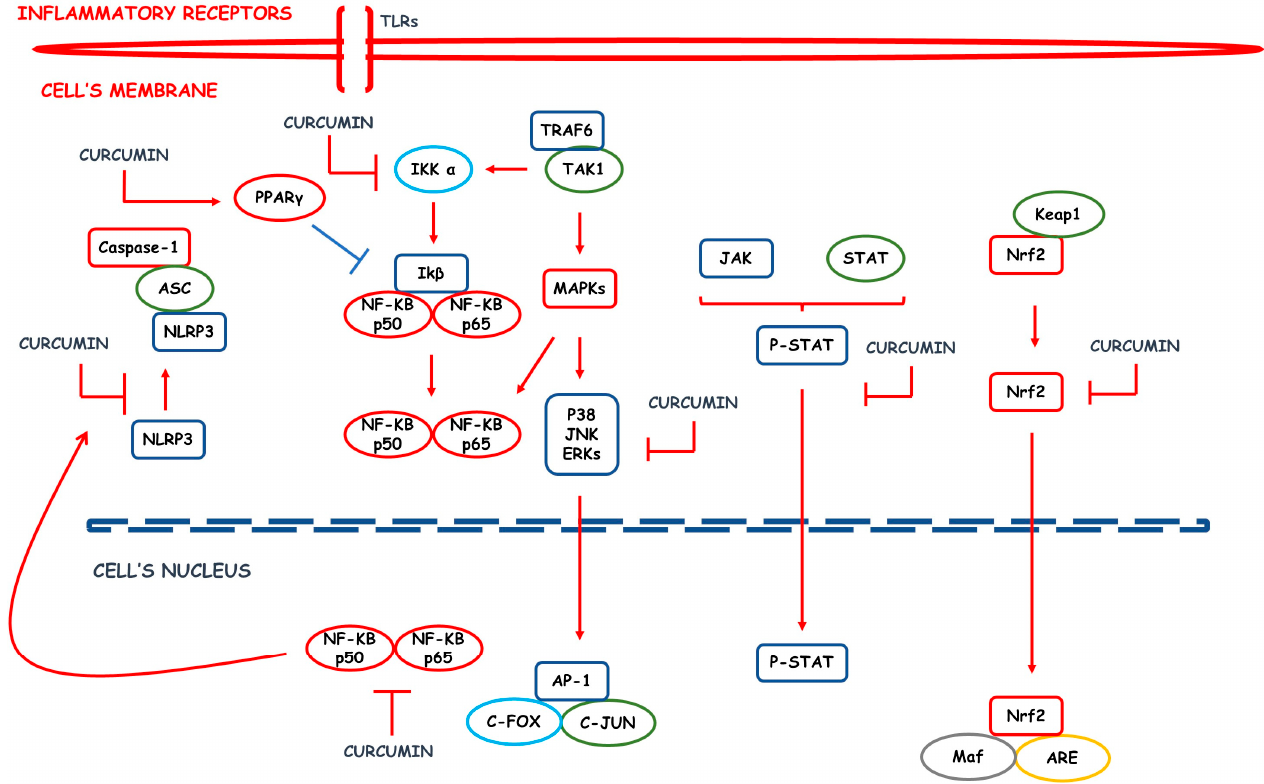
Figure 2. Most important pro-inflammatory vias involved in the occurrence of inflammatory bowel diseases that are inhibited by CUR. This bioactive compound diminishes inflammation and pro- motes antioxidant effects during in vivo, in vitro, and human studies regarding its use against IBD. The inhibition of NF-kB activation by CUR is highlighted. Ap1, apetala type 1; ARE, antioxidant redox element; ASC, apoptosis-associated speck-like protein; C-FOX, forkhead box protein C; C-JUN, transcription factor Jun C; ERK, extracellular signal-regulated kinases; IkB, nuclear factor of kappa light polypeptide gene enhancer in B-cells inhibitor; IKK a, I κ B kinases α ; JAK, Janus kinase; JNK, N-terminal kinase; Keap1, kelch-like ECH-associated protein 1; Maf, MAF BZIP Transcription Factor; MAPK, mitogen-activated protein kinase; NF-kB, nuclear factor kappa b; NLRP2, NLR family pyrin domain containing 3; Nrf2, nuclear factor erythroid 2–related factor 2; P38, p38 signaling transduction pathway; P50, NF-kB P50 heterodimer; P65, NF-kB P65 heterodimer; PPAR γ , peroxi- some proliferator-activated receptor γ ; P-STAT, phosphorylated STAT; STAT, signal transducer and activator of transcription; TAK1, transforming growth factor beta-activated kinase 1; TLRs, tool-like receptors; TRAF6, TNF receptor-associated factor